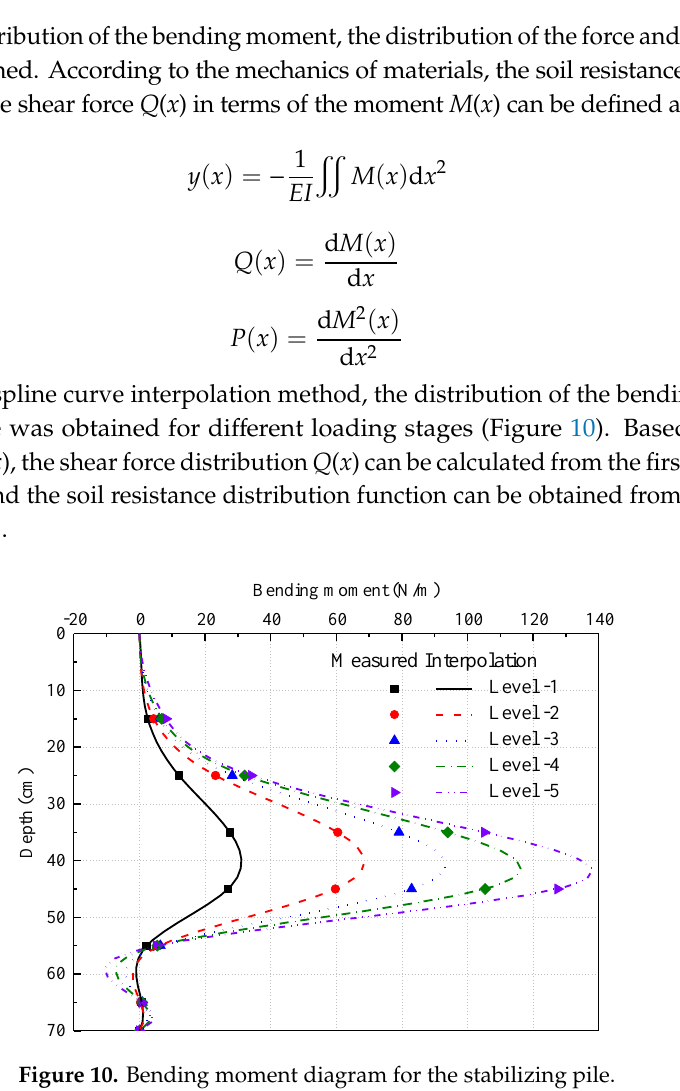
Figure 9. Top displacement of the stabilizing pile.